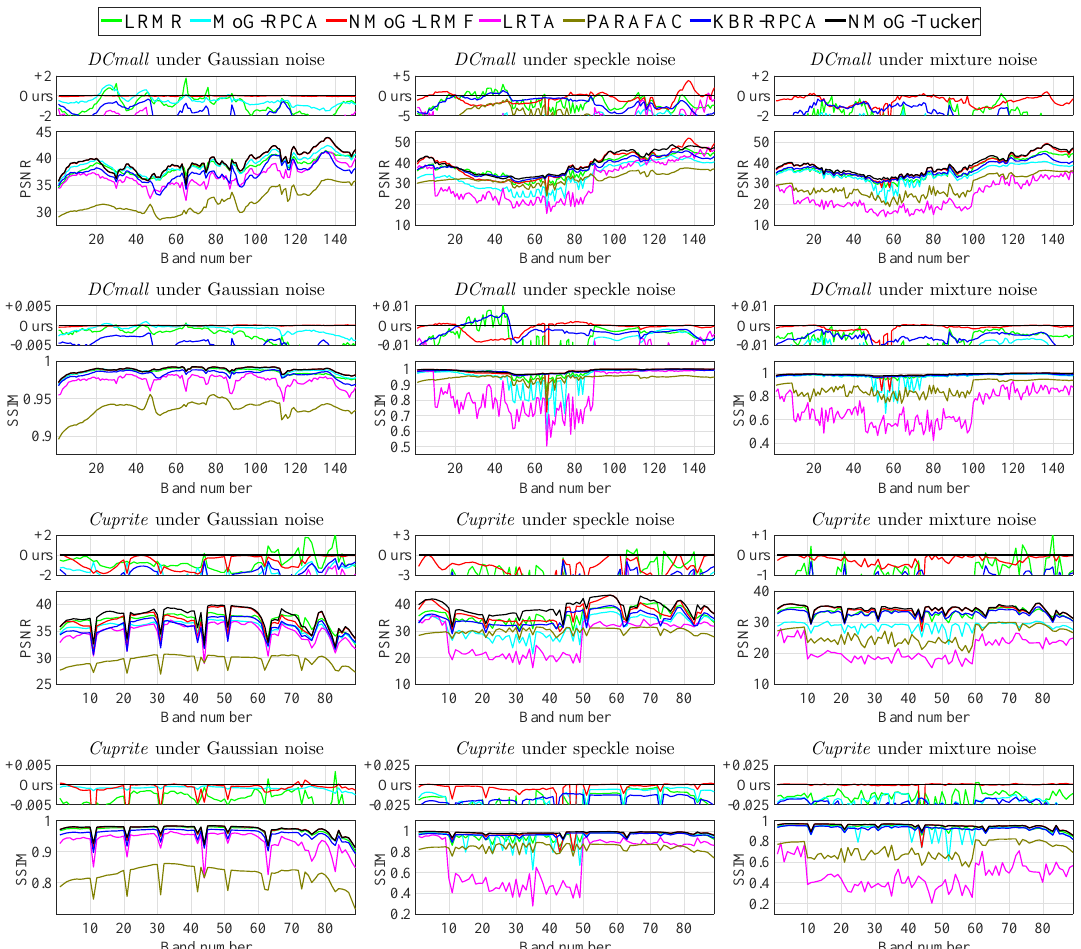
Figure 4. PSNR and SSIM values of each band for simulated HSI denoising. Differences between our results and the competing ones are plotted at larger